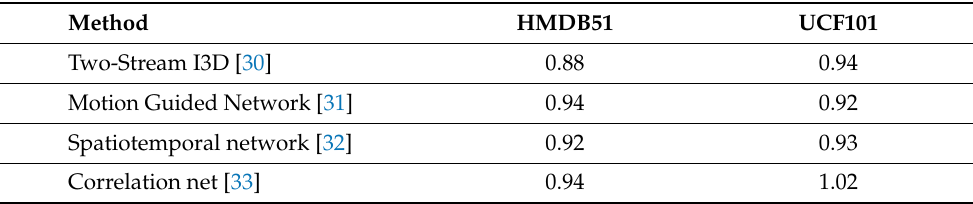
Table 6. Relative Runtime after adding the proposed method to the HAR systems under